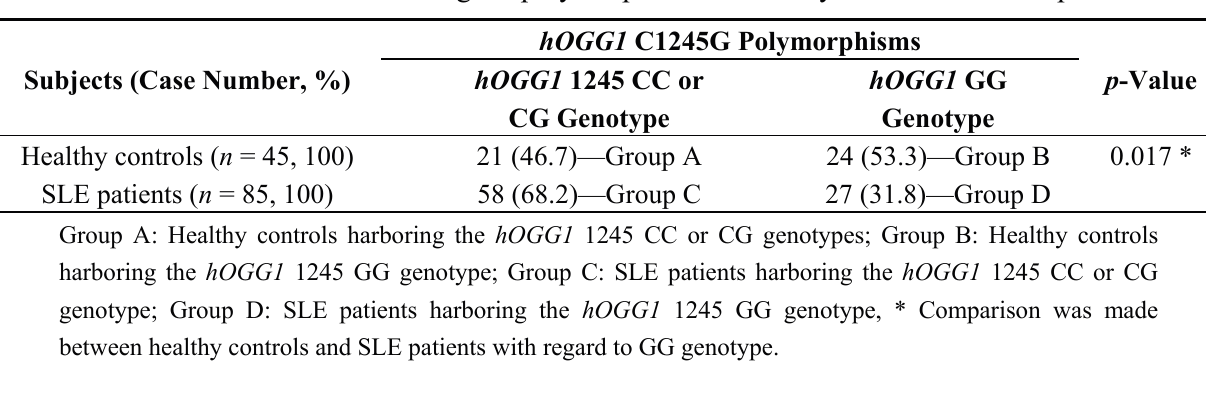
Table 1. Distribution of hOGG1 gene polymorphisms in healthy controls and SLE